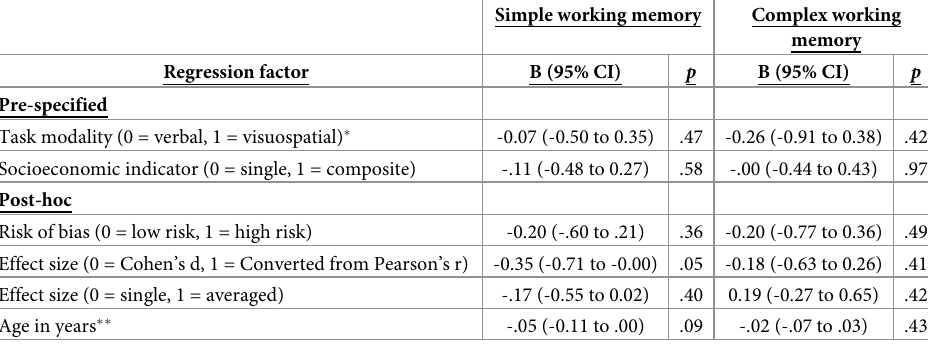
Table 1. Meta-regression analyses